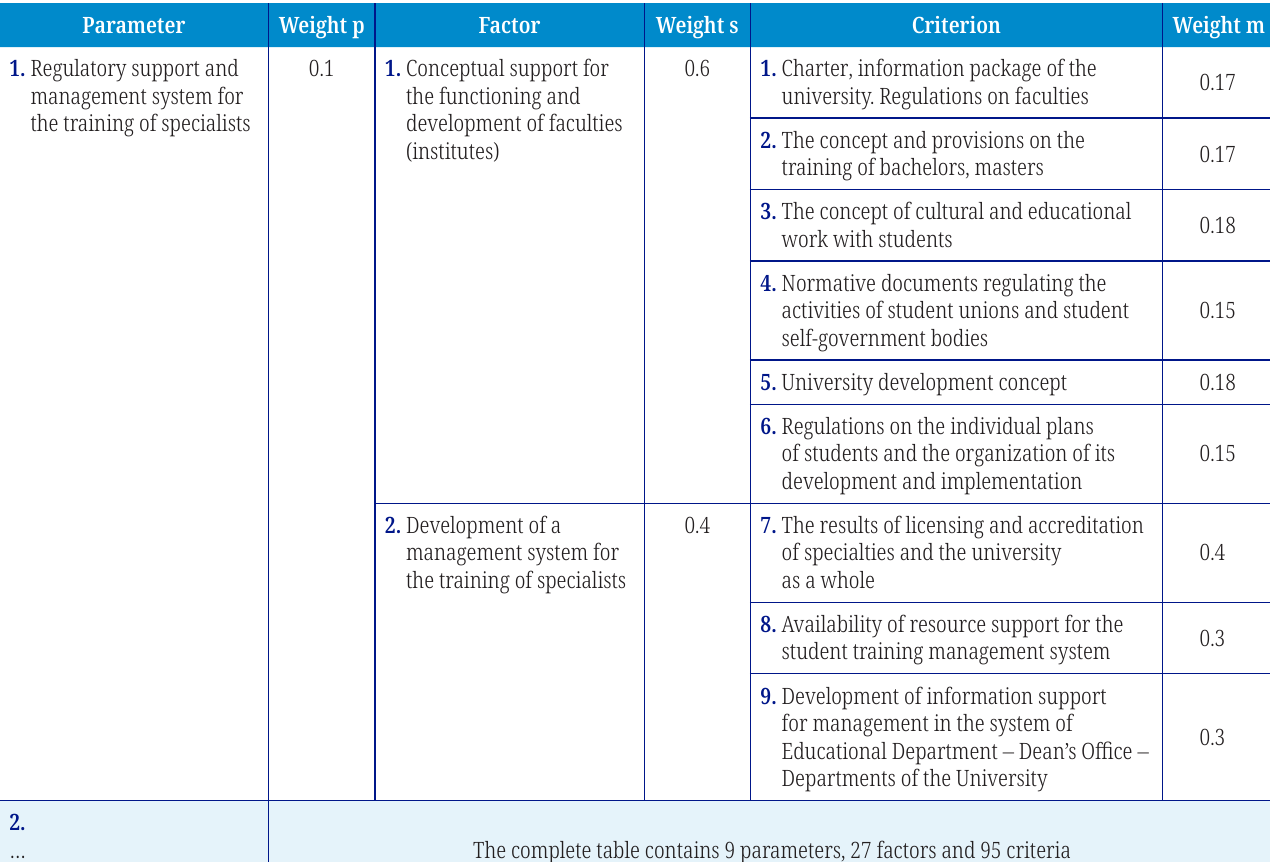
Table 1. Qualimetric model for assessing the quality of university education at Kharkiv National Pedagogical